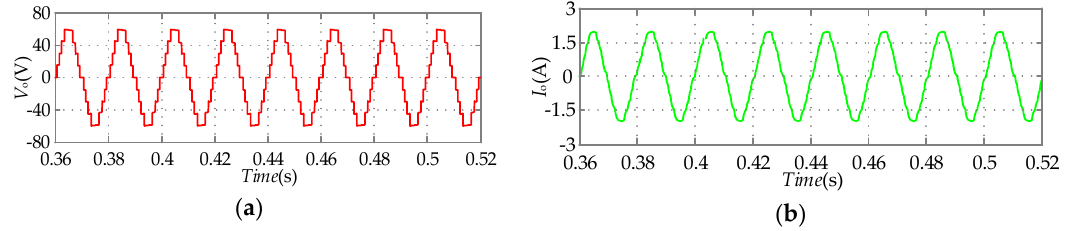
Figure 13. Waveforms of the nine-level inverter. ( a ) Voltage; ( b ) current.